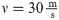
Example illustrating that drag can be closely approximated by the horizontal perturbation function ε(t).In this example, we simulate a ball with mass mb = 0.15 kg, radius rb = 0.0366 m, drag parameters cd = 0.5, A = πr2, ρ = 1.293 and initial conditions ν=30ms, φ=π4. The figure shows the ideal trajectory of the ball without drag (black line), with drag (blue line) and the fitted trajectory resulting by adding ε(t) = −1.11t2 to xb(t) (red dashed line). Note that ε(t) is different for every set of drag parameters and initial conditions.